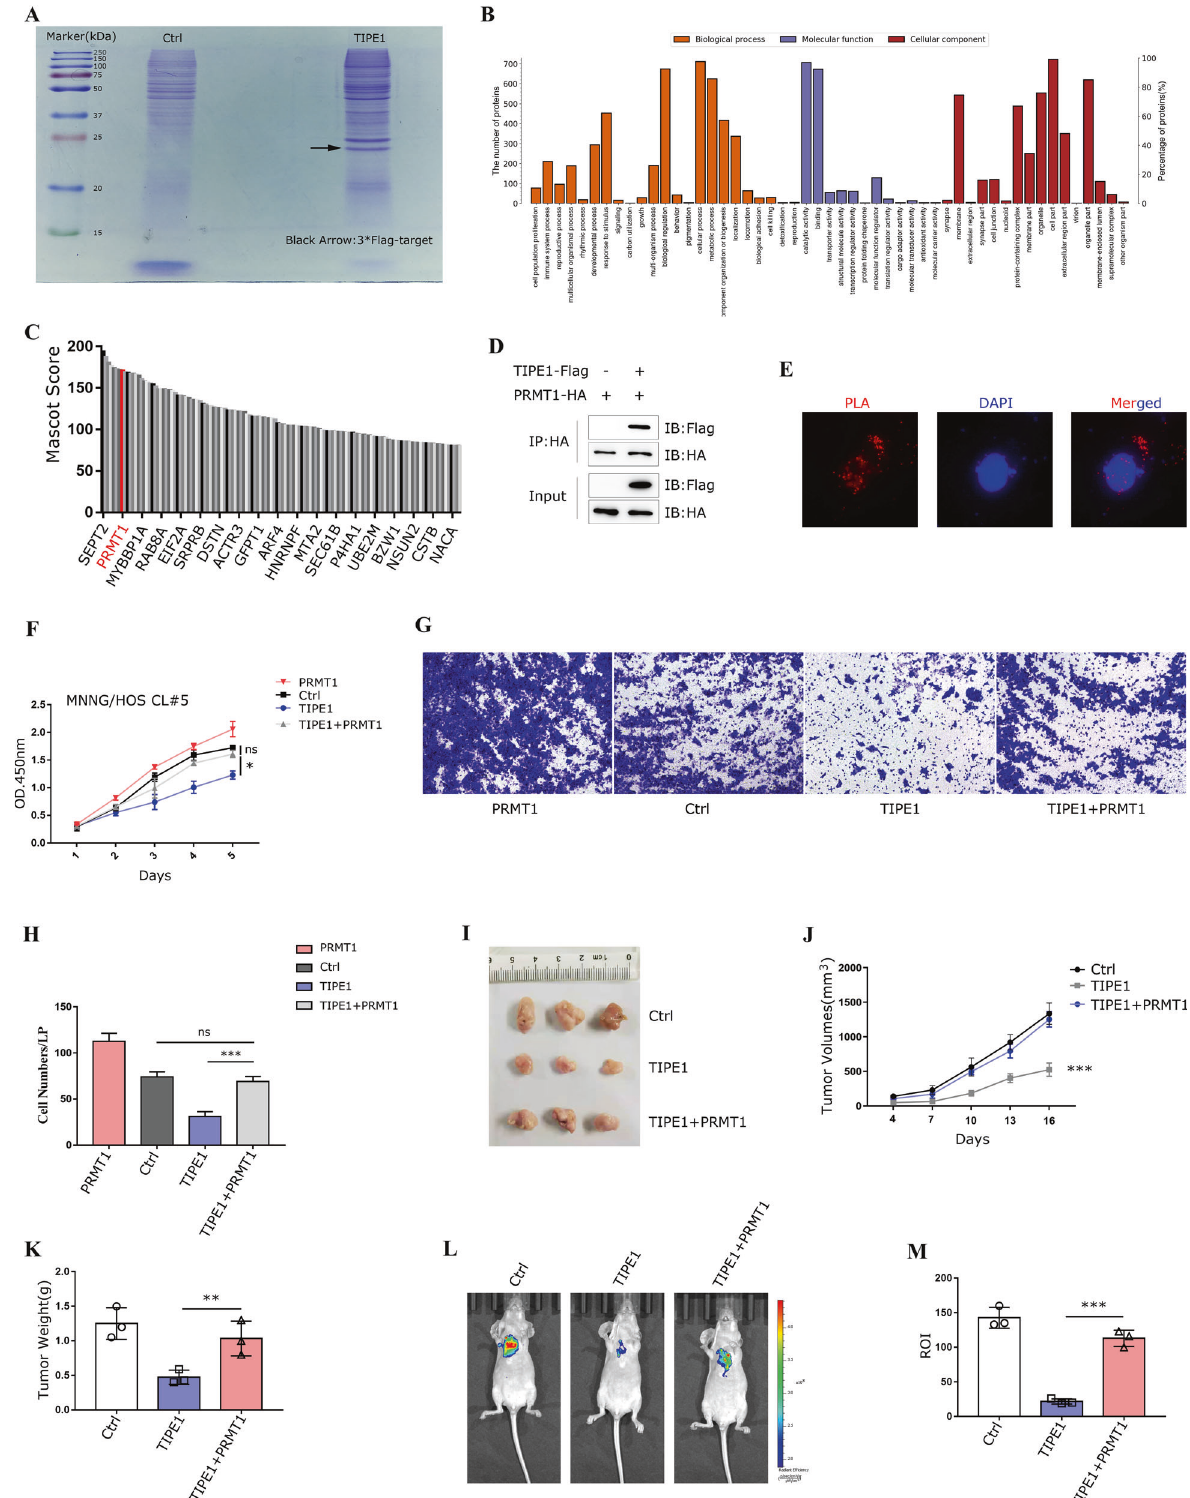
how TIPE1 affects the function of PRMT1. The results showed that TIPE1 can interact with truncated Δ 1, Δ 2 and Δ 4 vectors of PRMT1, which both contains catalytic domain as shown in Fig. 6A, demonstrating that TIPE1 interacts with the catalytic domain of PRMT1 and might inhibit its methyltransferase activity. To